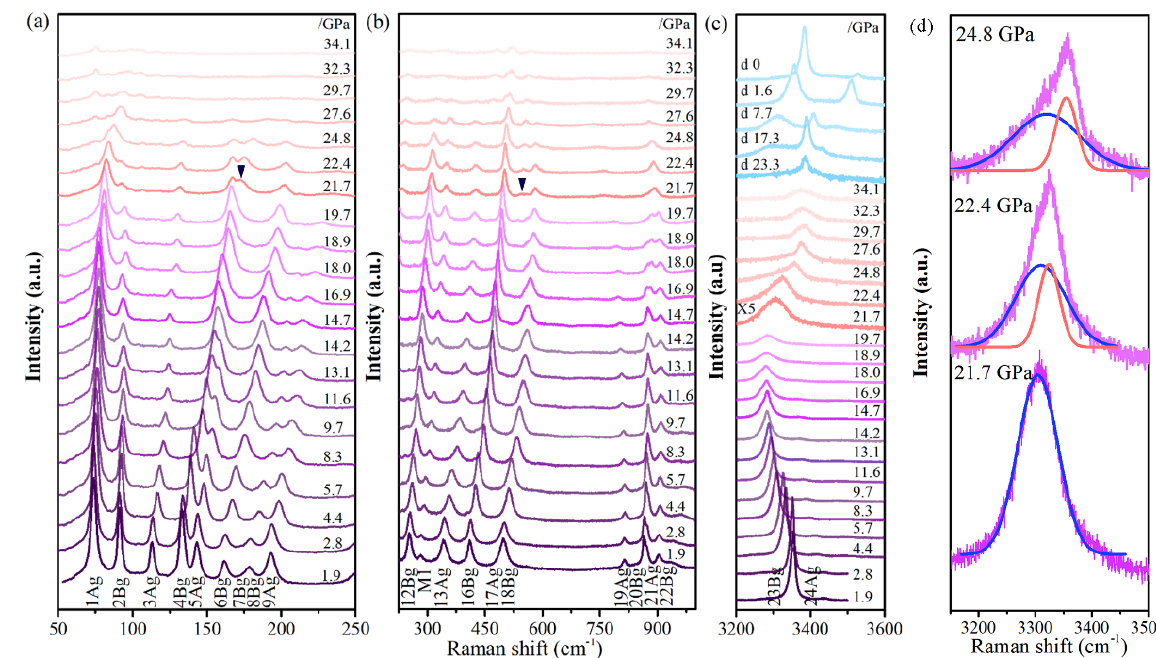
Figure 5. ( a – c ) Room-temperature Raman spectra of Cu(OH)Cl at selected pressures up to 34.1 GPa. ( d ) The enlarged picture of the Raman spectra at pressures of 21.7 GPa 22.4 GPa and 24.8 GPa.